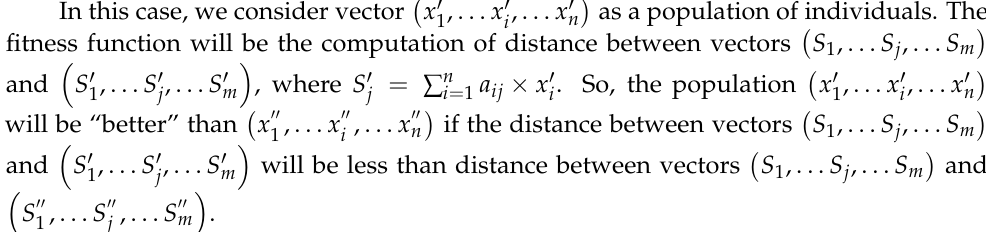
Figure 3. DRAKON visual programming language notation of the proposed evolutionary algo- rithm.